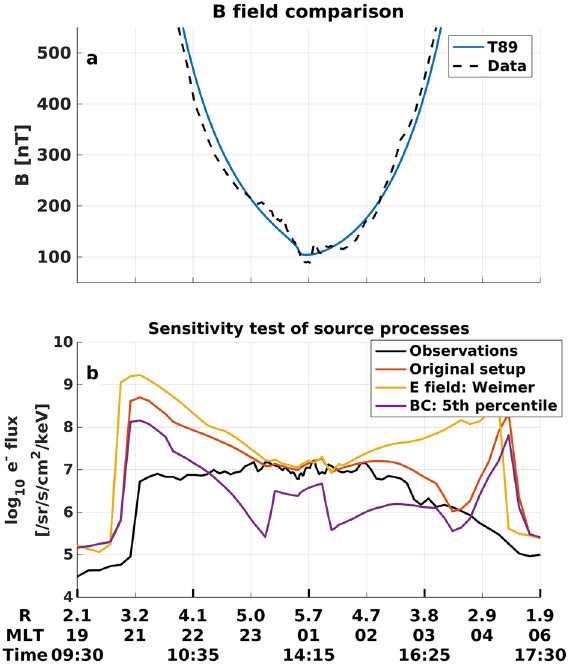
Figure 2. Sensitivity test of source terms of VERB-4D for the second orbit of RBSP-B during the March 2013 storm. (a) Comparison between T89 and RBSP EMFISIS observations of magnetic field magnitude along the RBSP-B orbit. (b) VERB-4D simulation results for 10keV electrons using the original setup (see Fig. 1), the Weimer electric field model 61 , and statistically low flux values at the outer radial boundary given by the 5th percentile of electron flux predicted by the Denton model 52